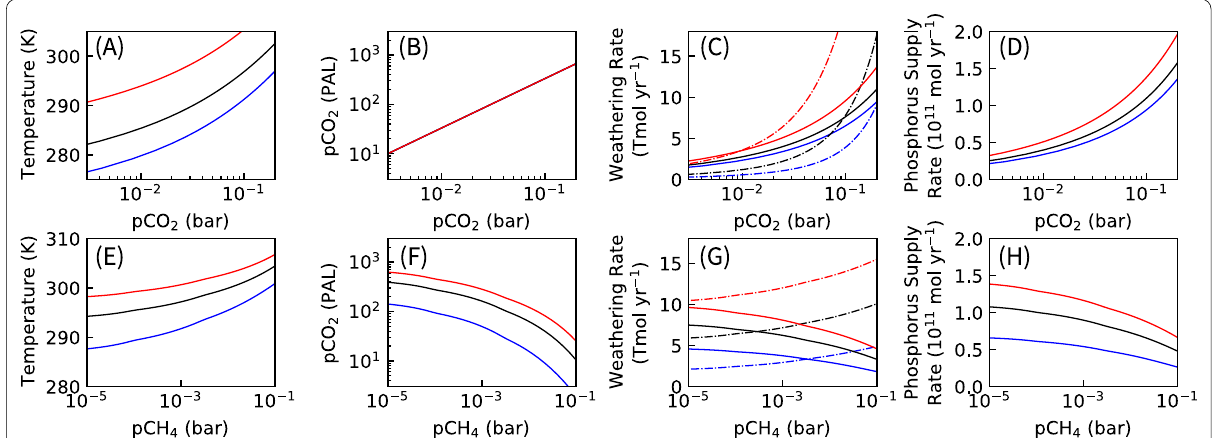
Fig. 2 Relationship between climate warmings and riverine phosphorus supply rate. Response of A the surface temperature (K); B atmospheric CO 2 level (present atmospheric level; PAL); C continental/seafloor weathering rate (Tmol year –1 ) (solid line/dot-dashed line), and D the riverine phosphorus supply rate (10 11 mol year –1 ) to CO 2 -induced warming at a fixed p CH 4 (blue: 1.00 (bar)). Similarly, response of E the surface temperature (K); F atmospheric CO 2 level (PAL); G continental/seafloor weathering rate (Tmol year − 1 ), and